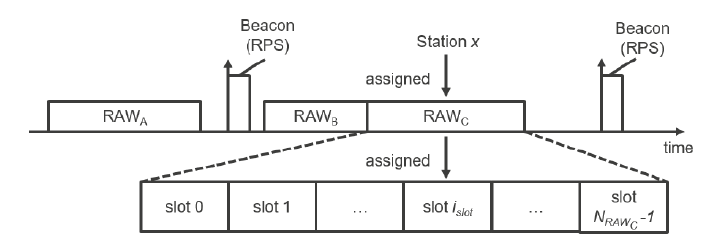
Figure 1. RAW assignment taken from